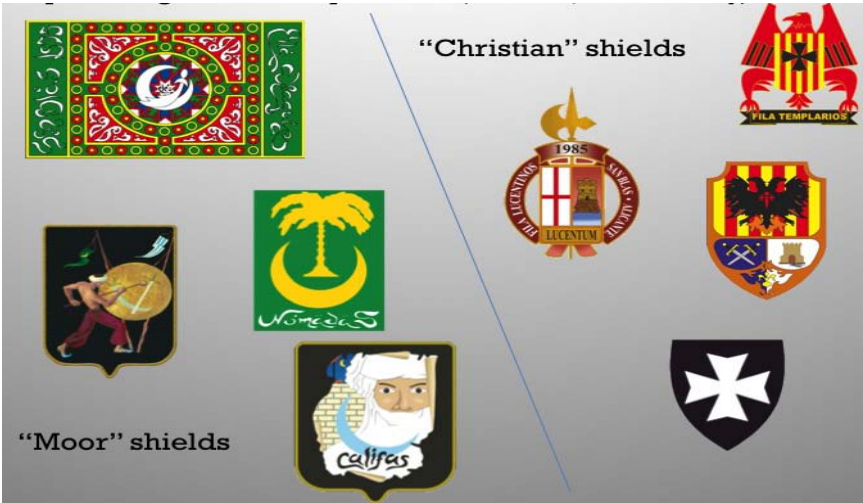
Images provided Asociación de Moros y Cristianos de San Blas